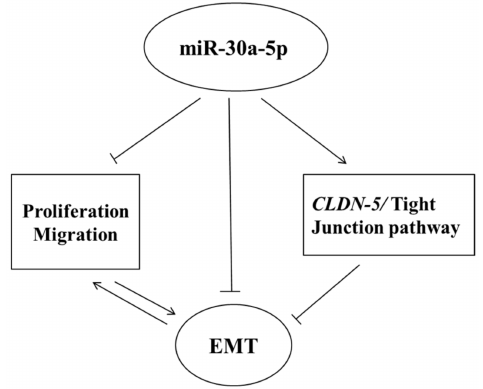
Figure 8. Proposed effects of miR-30a-5p on UTUC. The miR-30a-5p-enhanced CLDN-5 expression may trigger tight junction pathway signal transduction. Moreover, miR-30a-5p suppresses the EMT process via increasing E-cadherin and suppressing vimentin, fibronectin, and α -SMA expression, thereby inhibiting the migration activity of UTUC